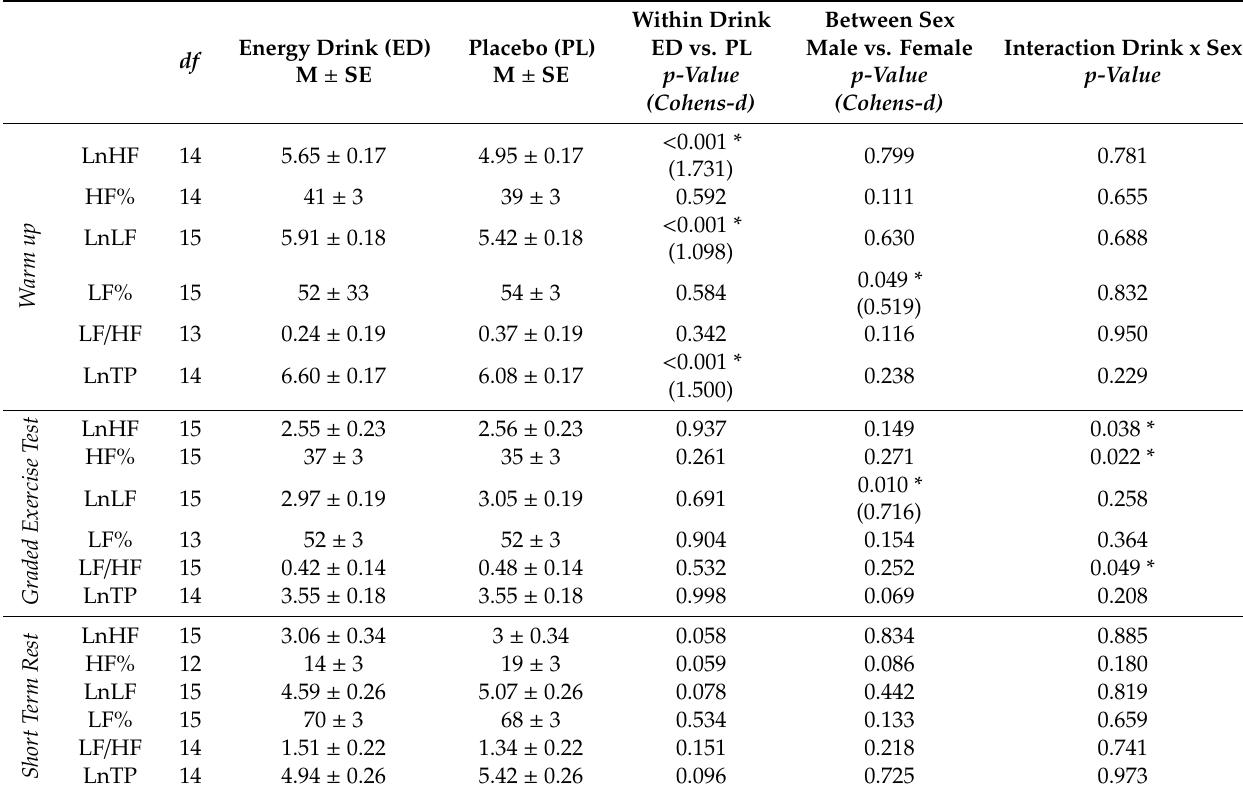
Table 1. Comparison of frequency domain parameters during warm up, graded exercise test, and short-term recovery 15 min post